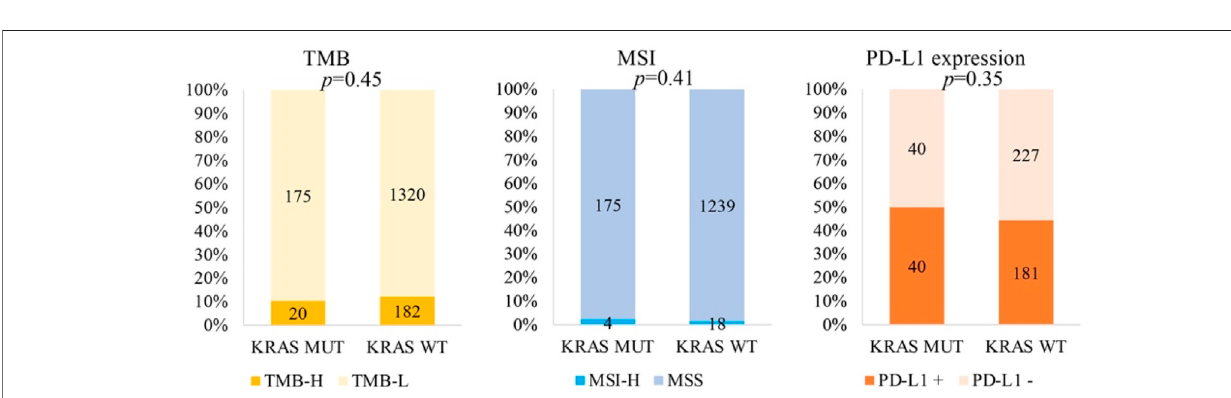
FIGURE 3 | Correlation of KRAS with immunotherapeutic molecular